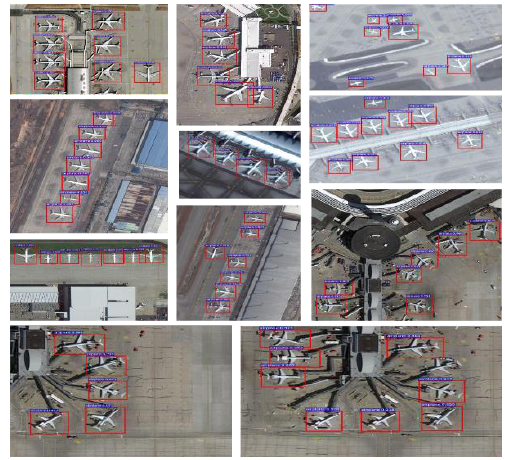
Figure 3. Airplane candidate regions detecting